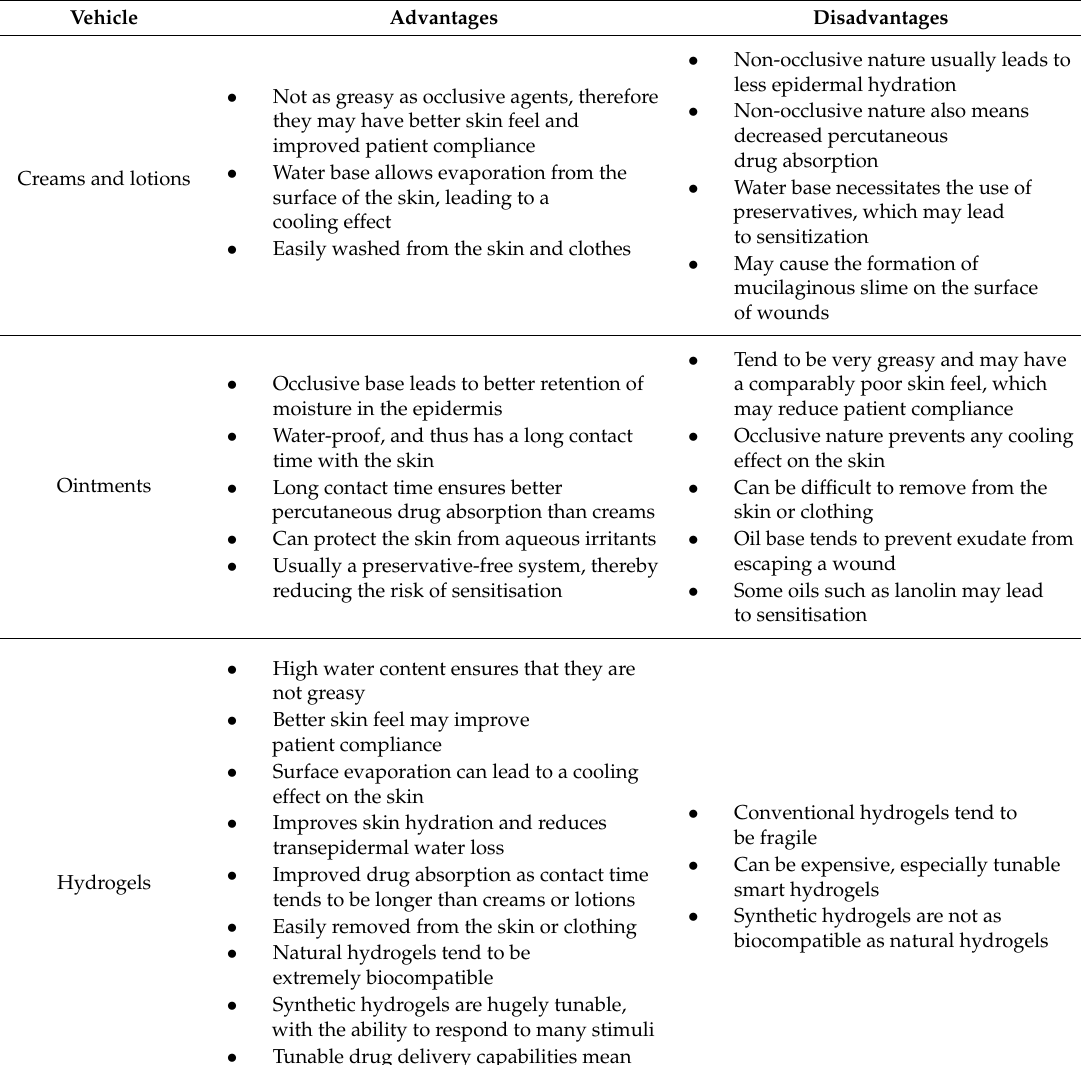
Table 1. Advantages and disadvantages of hydrogels compared with the most common drug-delivery